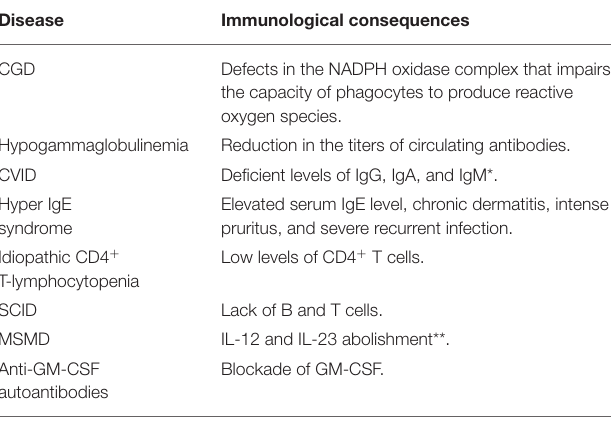
TABLE 2 | PIDs that can cause